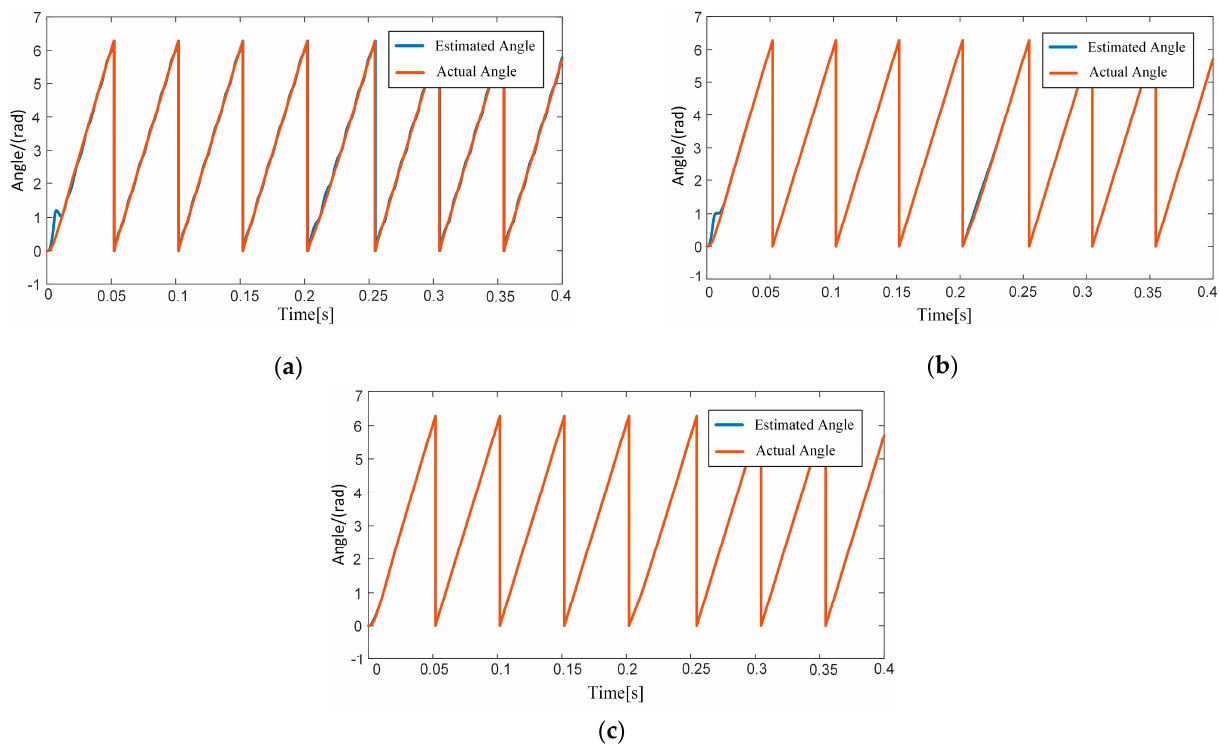
Figure 11. Angle estimation waveform: ( a ) The traditional sliding mode; ( b ) the traditional sliding mode + dead zone compensation; ( c ) adaptive sliding mode observer + dead zone compensation.